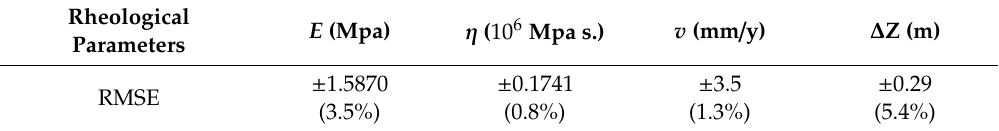
Table 1. Comparison of root mean square error (RMSE) for each parameter in the simulated experiment. Rheological